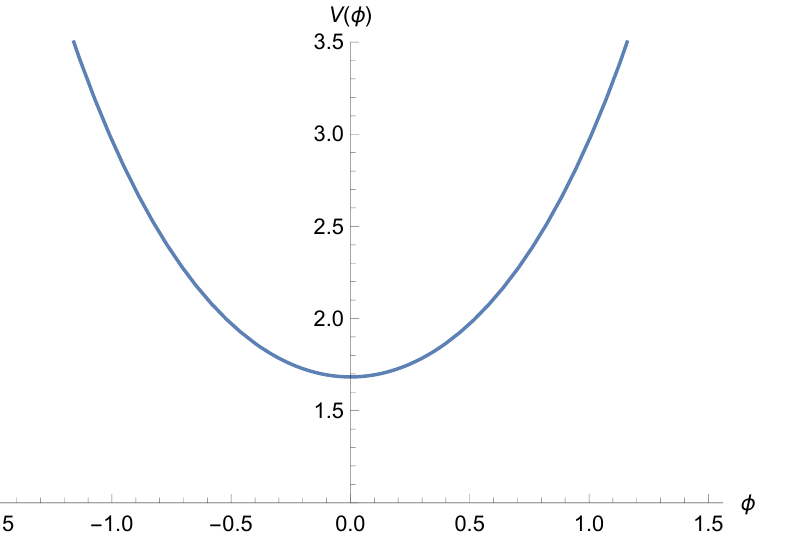
√ p 1 p 2 p 3 as function of φ : the Big Bounce